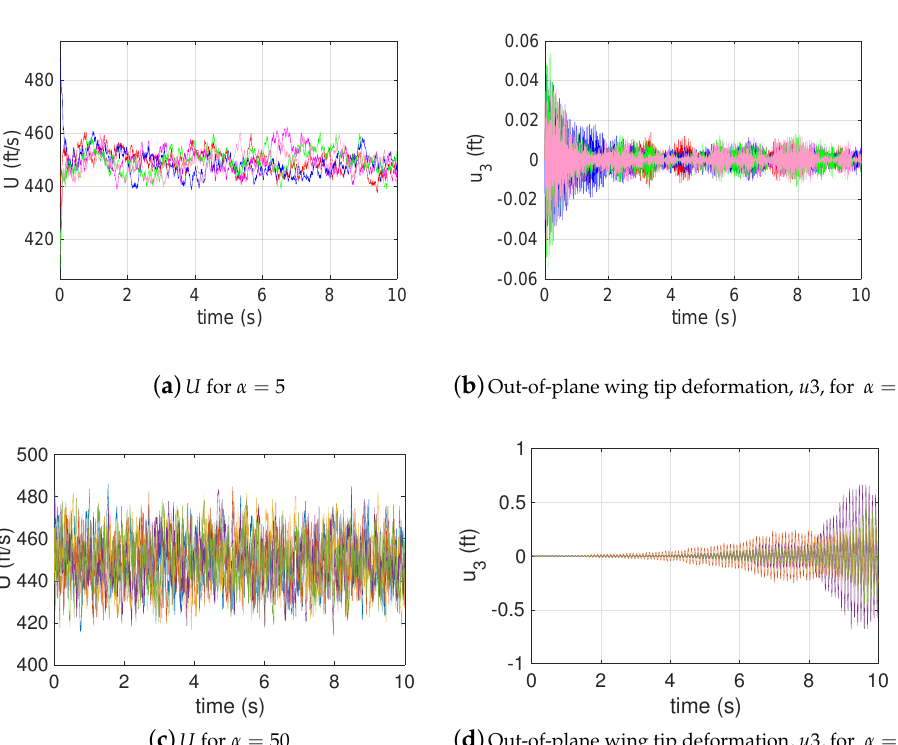
( d ) Out-of-plane wing tip deformation, u 3, for α = 50 Figure 19. Goland Wing Oscillation with correlation function, r xx = e − ατ , where U ave = 450 ft/s, and ∆ = 0.1.